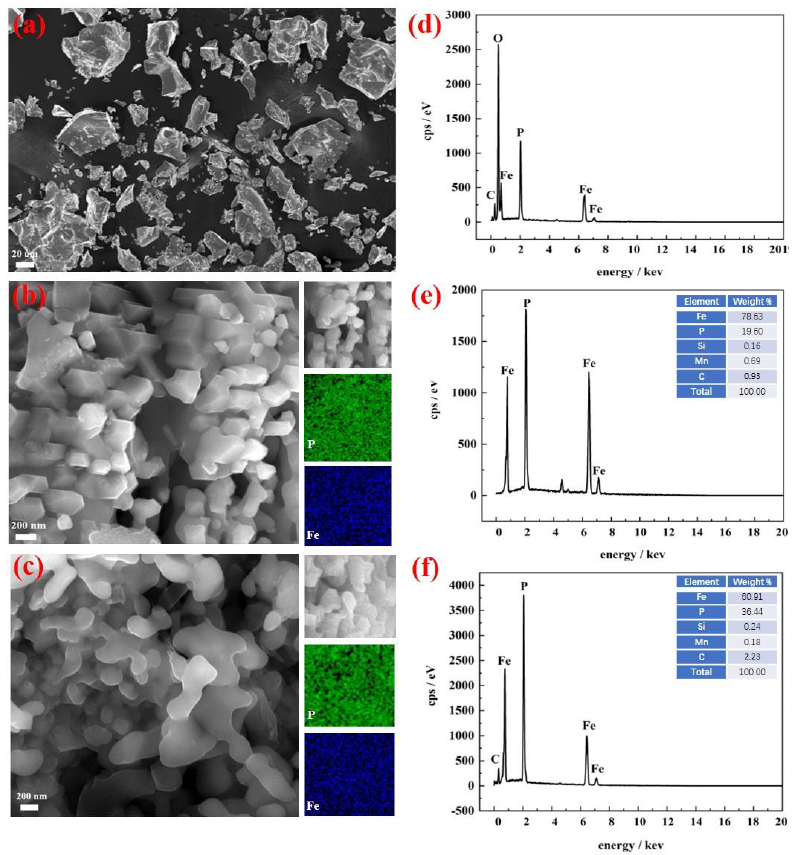
Figure 1. SEM image and corresponding EDS spectra of ( a , d ) dephosphorization slag, ( b , e ) Fe x P, ( c , f ) Fe x P/C. The inserts in ( b , c ) are selected SEM images and the corresponding elemental mapping images. The inserts in ( e , f ) are the corresponding elemental weight% from EDS data.